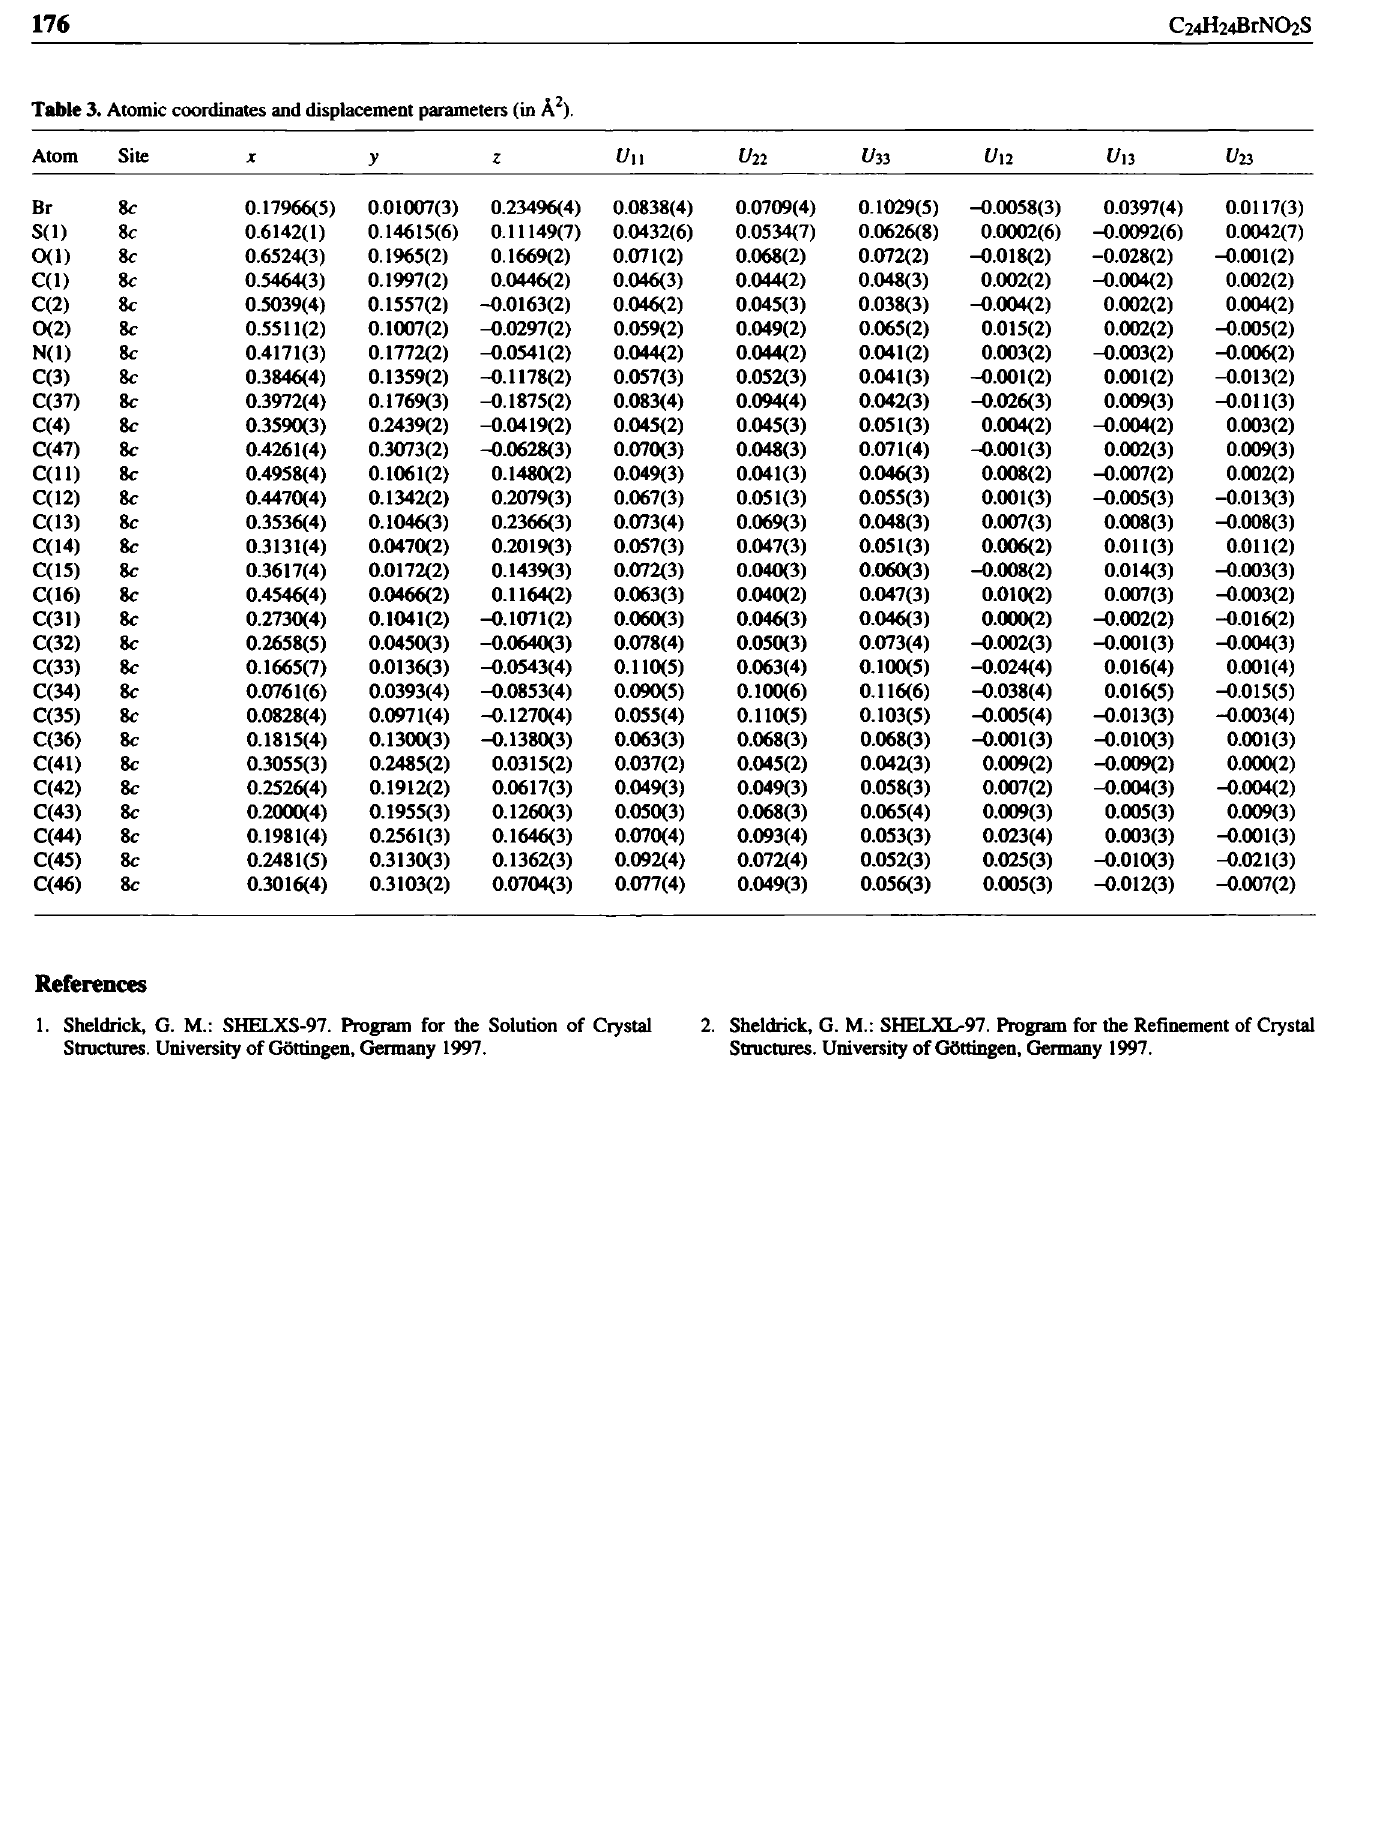
Table 3. Atomic coordinates and displacement parameters (in Ä 2